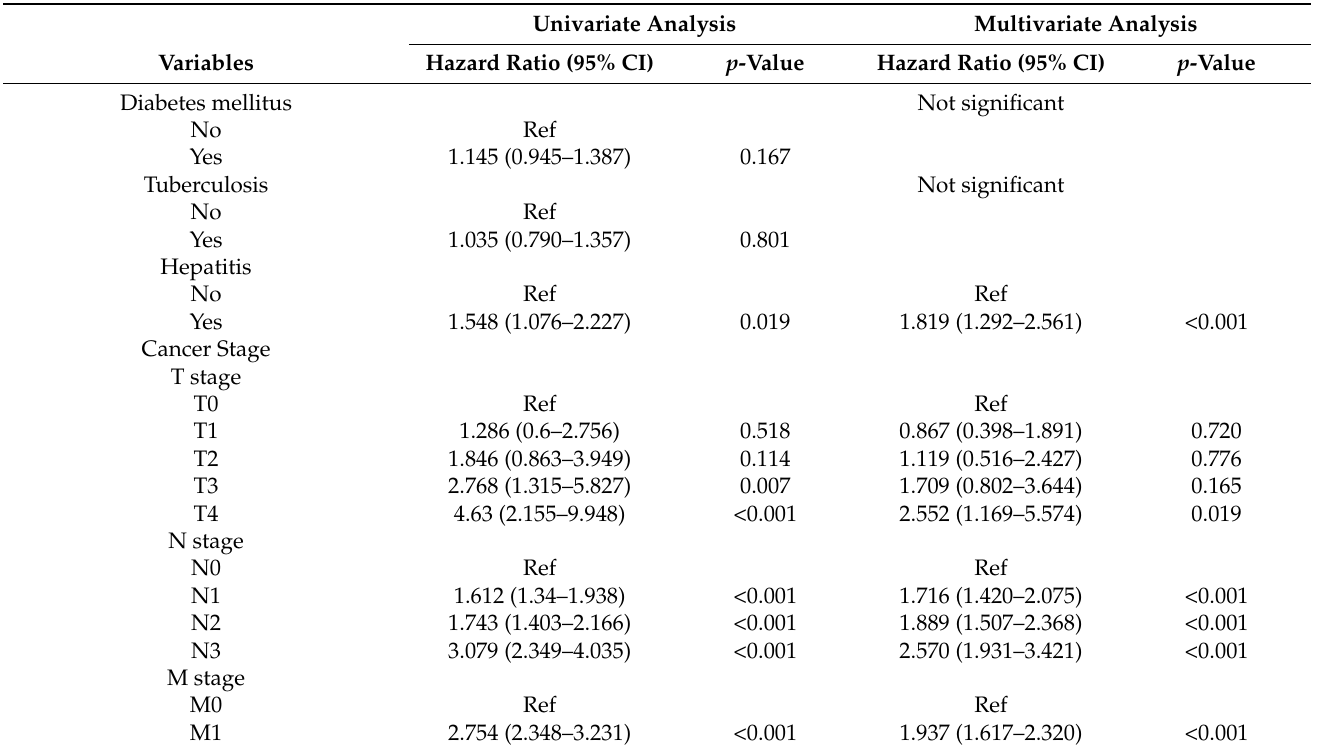
Table 3. Cont. Univariate Analysis Multivariate